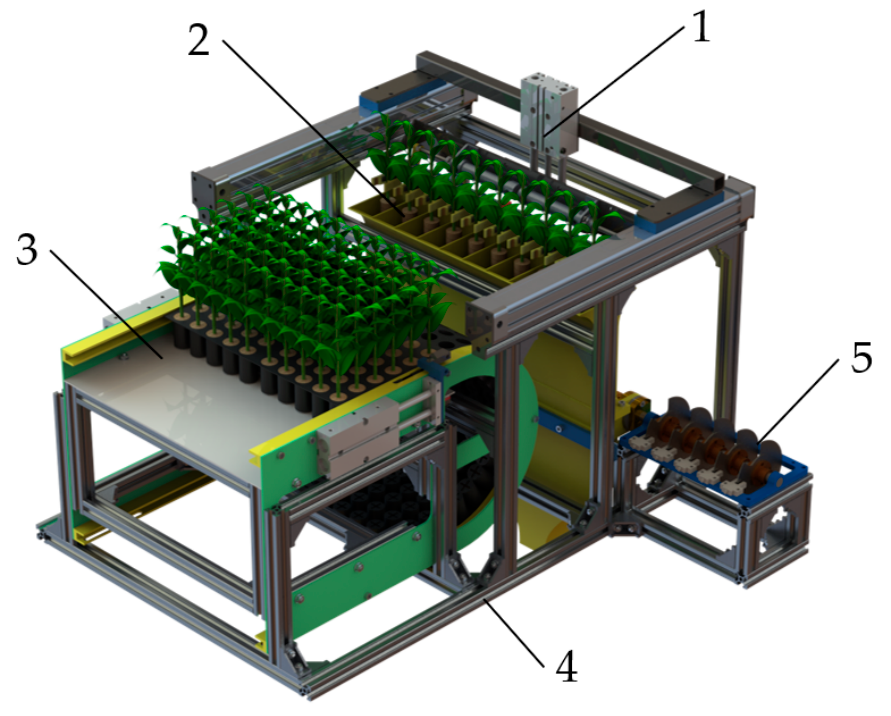
interval length to W 2 , corresponding to the width of the seedling dropping mechanism, thus disrupting the interlacing of the seedling leaves and preventing the seedlings from hanging on the spacer between each seedling tube within the seedling tray when the whole row of seedlings is dropped.